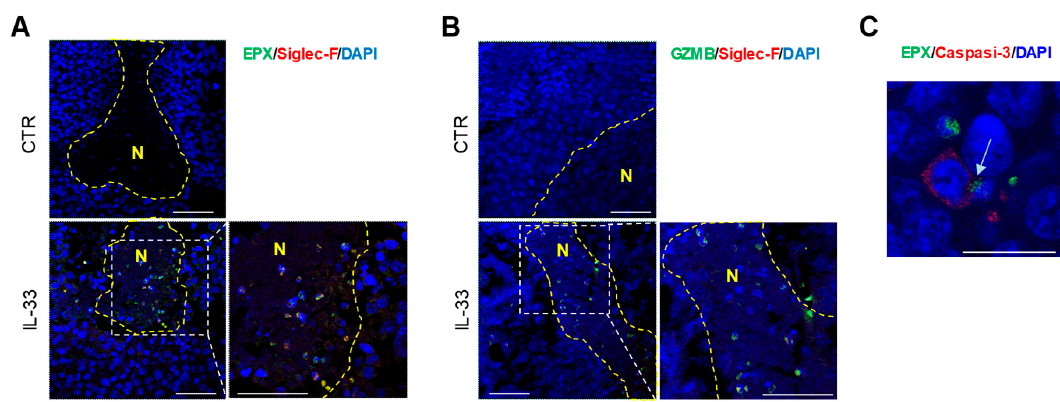
Figure 6. Detection of degranulating tumor-infiltrating eosinophils in mice treated with IL-33. CLSM analysis of tumor tissue sections from untreated (CTR) or IL-33 treated mice stained for EPX, Siglec-F, GZMB or Caspase-3 detection. Merged images (three-dimensional reconstruction) of ( A ) EPX / Siglec-F, ( B ) GZMB / Siglec-F and ( C ) EPX / Caspase-3 are reported. Co-localizations are shown in yellow. Inserts represent higher-power magnification images of necrotic areas (N) with EO infiltration in tissues from IL-33 treated mice. Nuclei are stained with DAPI (blue). Scale bars correspond to 50 µ m ( A , B ) or 20 μ m ( C ). Panels are representative of 2 independent experiments.